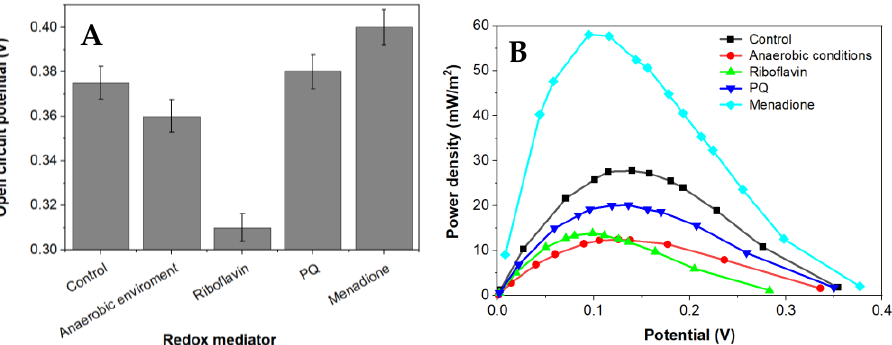
Figure 4. The dependence of capabilities to generate an electrochemical potential of Rhizobium anhuiense in 0.1 mM PBS, pH 7.0, the presence of several redox mediators (5 mM of menadione, 0.2 μM of riboflavin, and 4 mM of 9,10-phenanthrenequinone), and under anaerobic conditions. ( A ) the OCP values in presence of different redox mediators and ( B ) the dependence of power density on the potential value.